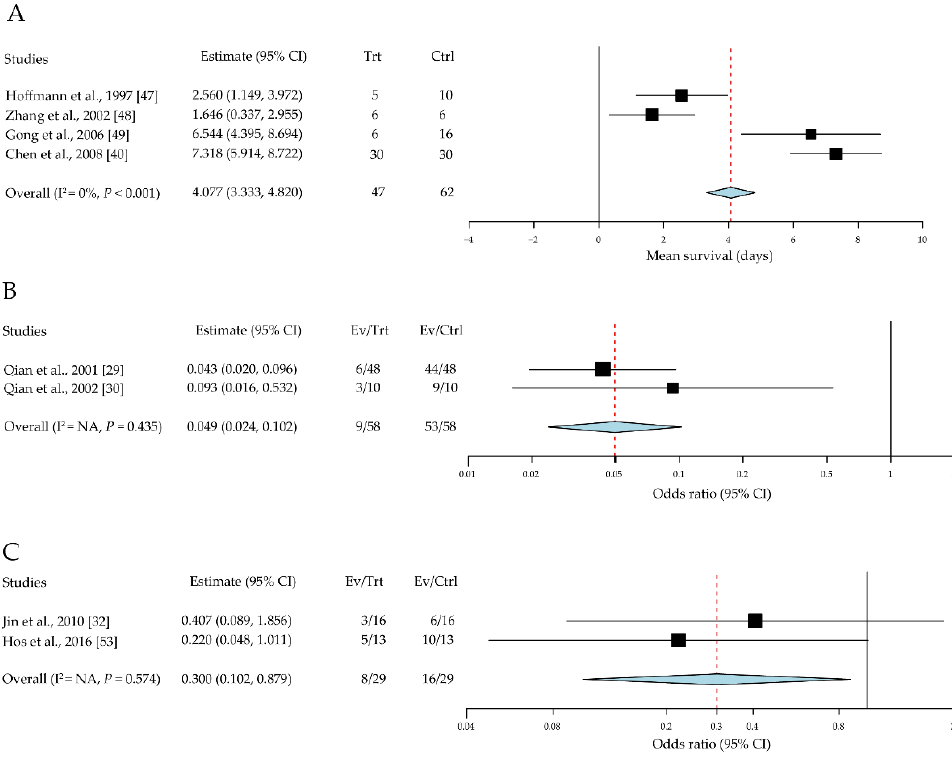
Figure 5 . Regulatory T cells prolong corneal allograft survival. CI, confidence intervals; EV, event; Trt, treatment; Ctrl, control.